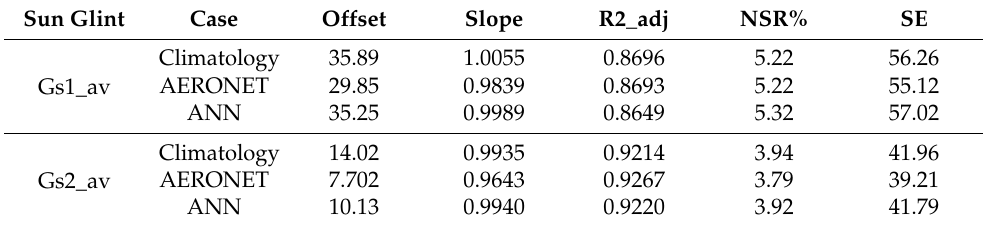
Figure 5. Comparison between different processing options for ( a ) Gs1_av; and ( b ) Gs2_av. Table 6. Statistical results for Figure 5. Offset, NSR and SE are 10,000 ×